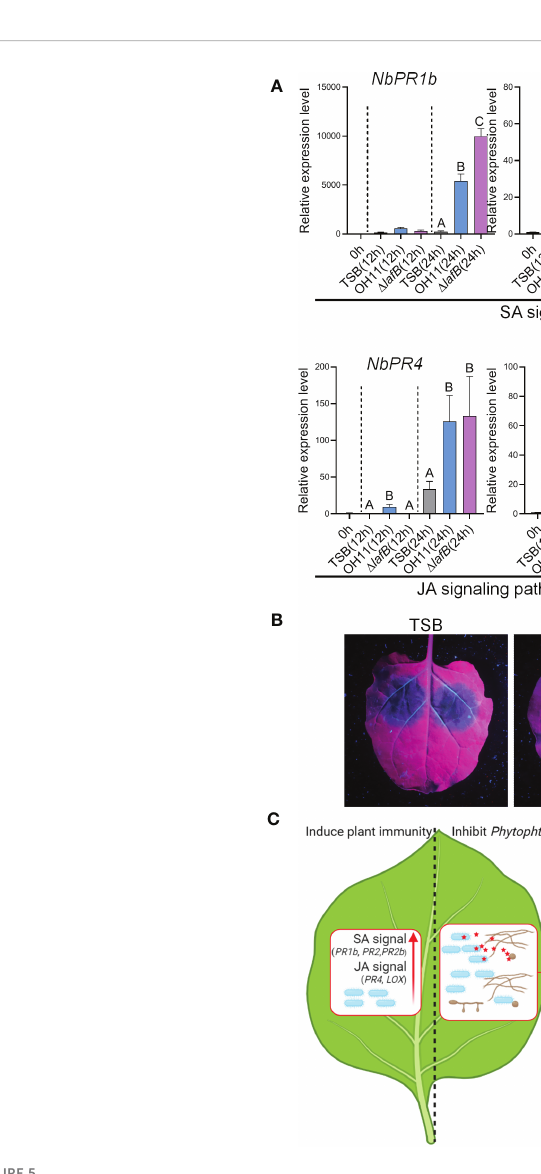
FIGURE 5 L. enzymogenes OH11 treatment elicited immunity responses in N. benthamiana . (A) Treatment of wild-type OH11 and HSAF-de fi cient mutant D lafB up-regulated expression levels of defense-related genes in N. benthamiana leaves. Gene expression levels were measured 12 and 24 hours after treatment, respectively. The relative expression level of untreated leaves (0h) was set to 1.0. Three replicates of each sample were analyzed using a one-way ANOVA test. (B) Pretreatment with WT and D lafB prevented infection of N. benthamiana leaves from P. capsici . P. capsici